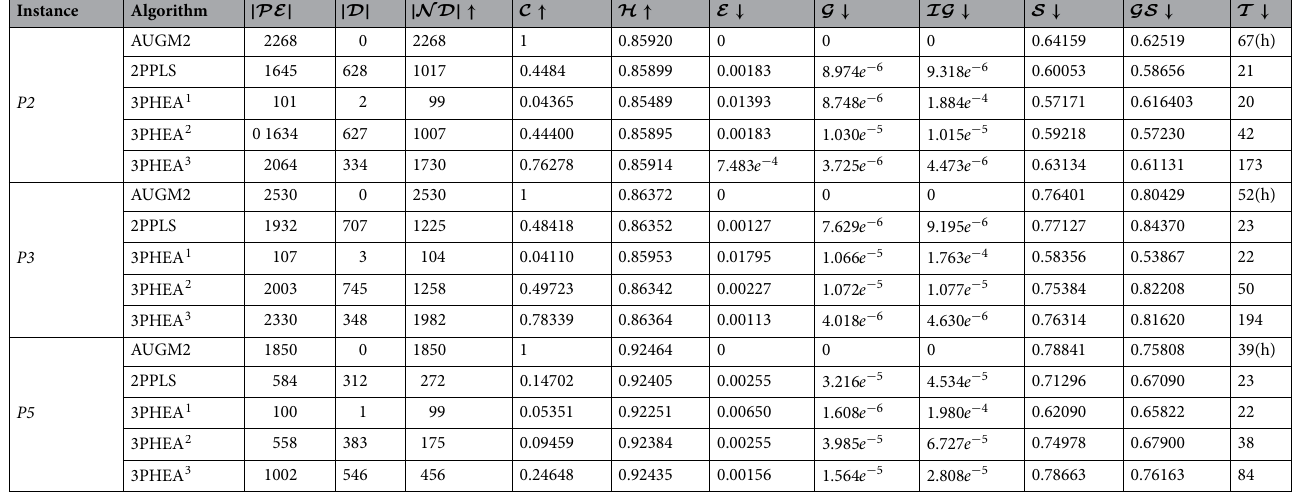
Table 6. Experimental results for datasets (Stützle and Paquete 61 ). | PE | : Number of potentially efficient